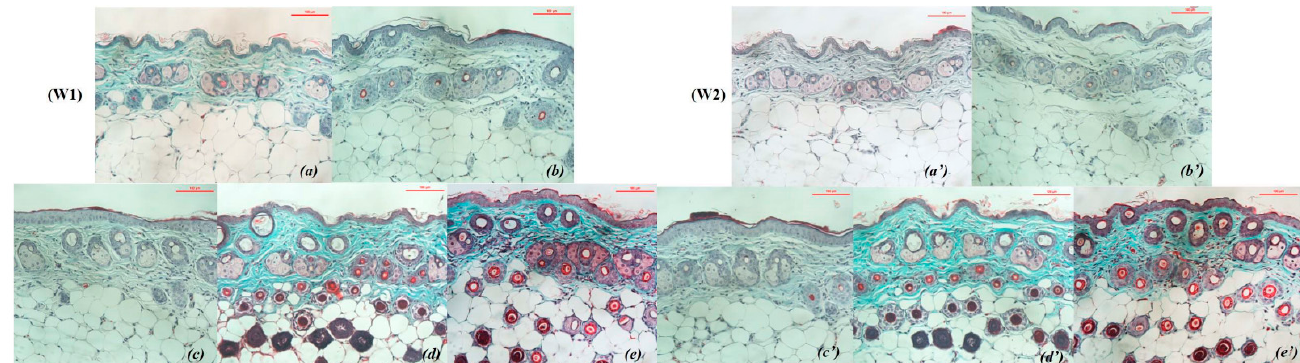
Figure 6. Trichrome-stained mouse skin structure after 2 weeks of treatment (X20): (W1—after